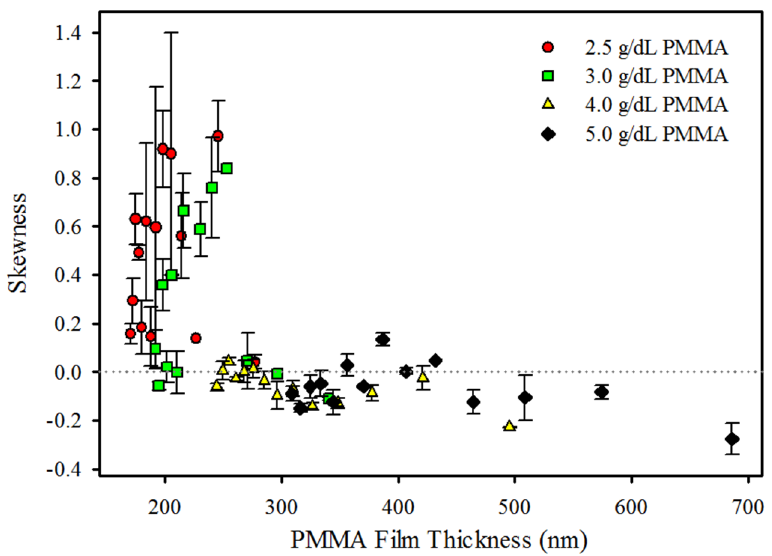
Figure 7. PMMA surface skewness as a function of final film thickness. Films were cast using 2.5, 3.0, 4.0, and 5.0 g/dL solutions spun at speeds from 400 to 3000 RPM. 4.0, and 5.0 g/dL solutions spun at speeds from 400 to 3000